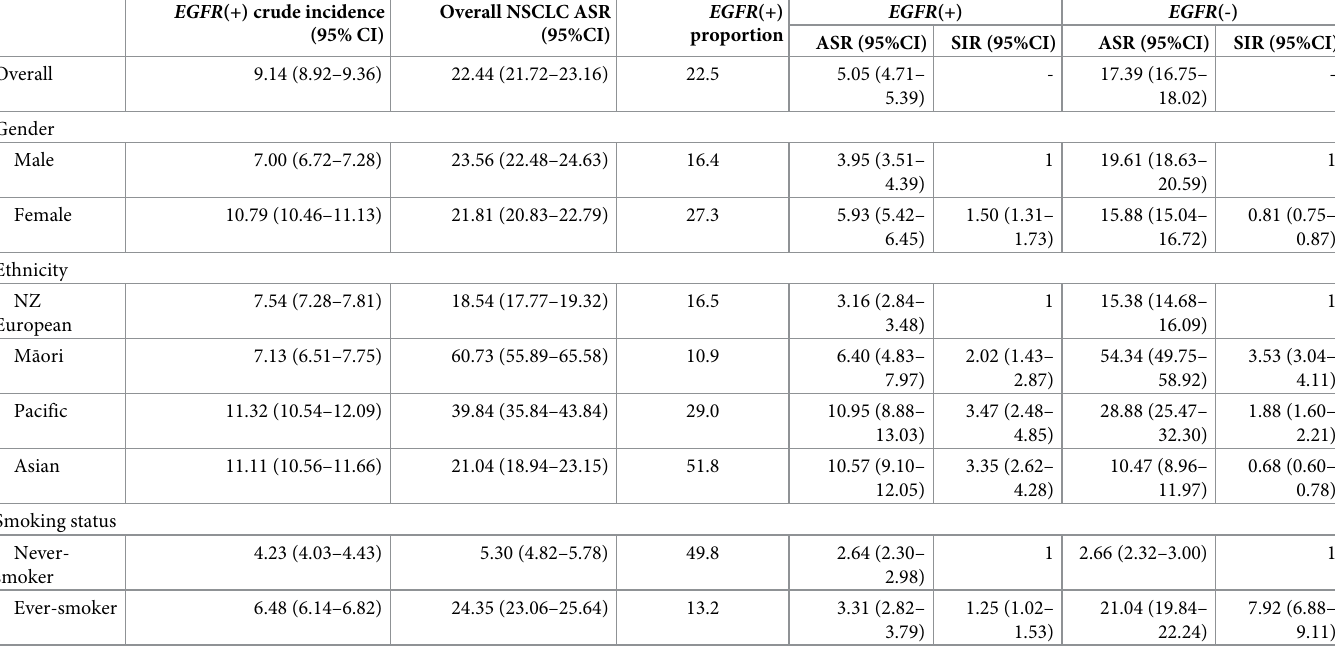
Table 2. Incidence rates of non-squamous non-small cell lung cancer by EGFR mutation status, showing the estimates based on the EGFR mutation tested proportions. EGFR (+) crude incidence (95%